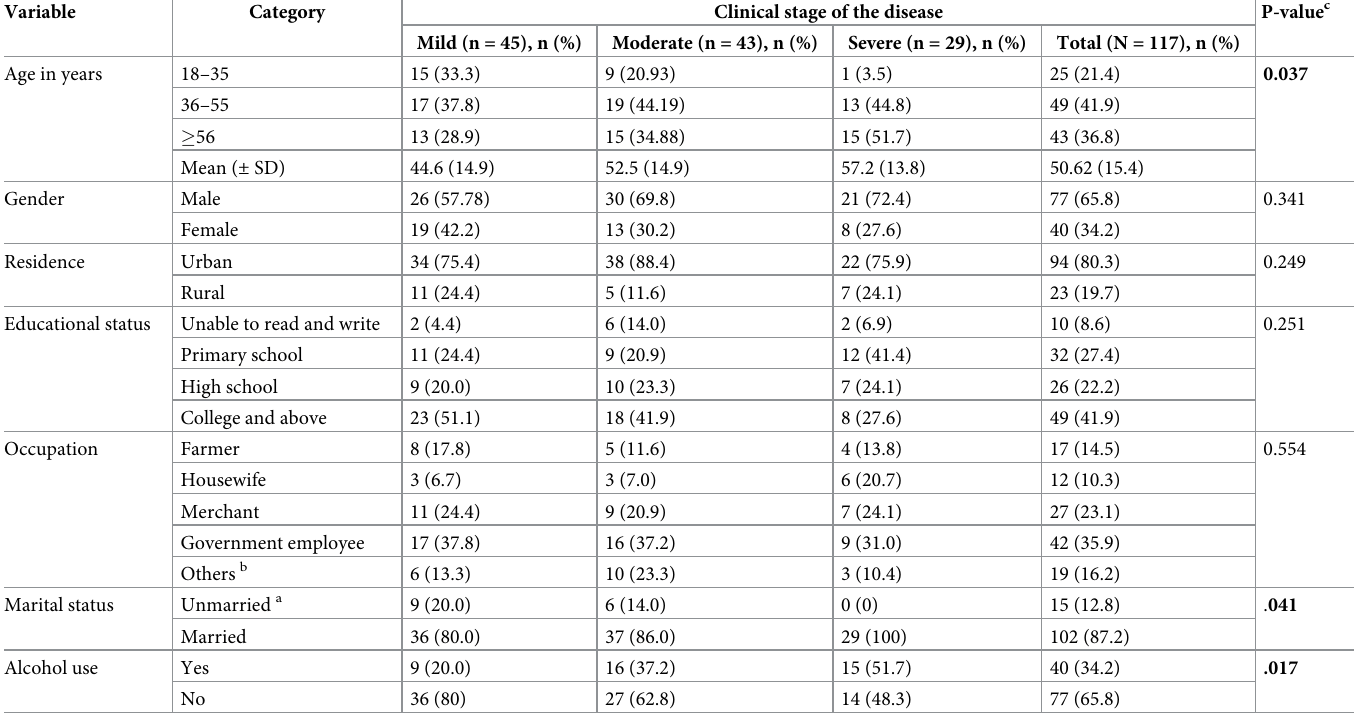
Table 1. Socio-demographic and behavioral characteristics of study participants attending at the Tibebe Ghion Specialized Hospital, COVID-19 treatment center 2021 (n =